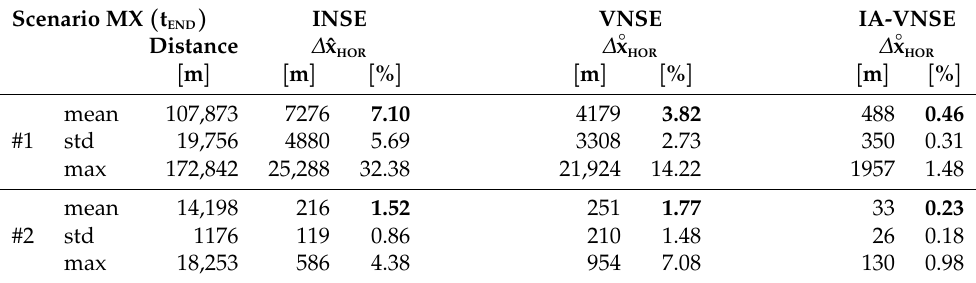
Table 6. Aggregated MX final horizontal position INSE, VNSE, and IA-VNSE (100 runs). The most important metrics appear in